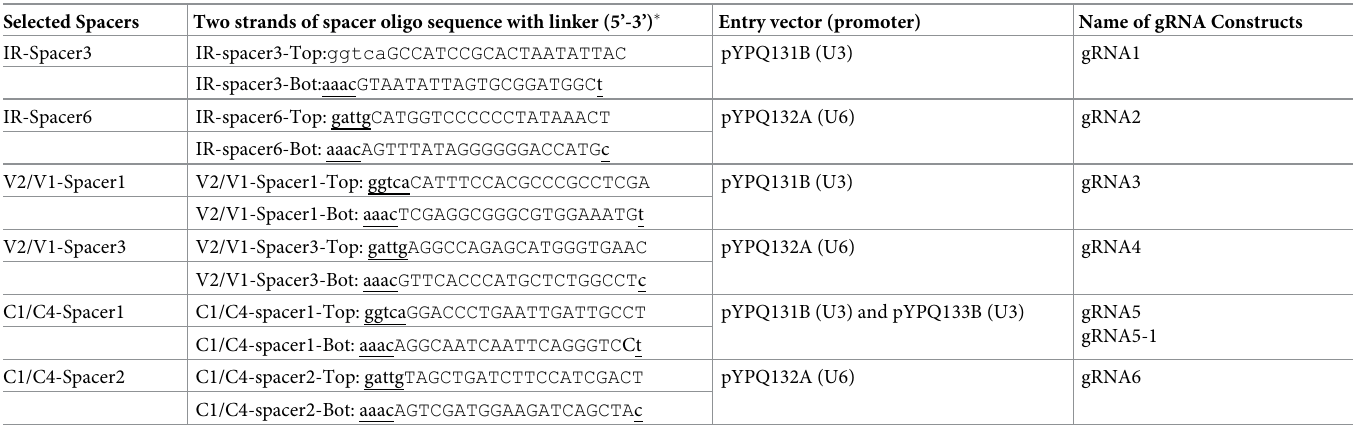
� Spacer sequences (Top) and its complimentary sequences (Bot) were synthesized with addition of linker (underlined) as required for their cloning into GoldenGate entry vectors. The Top and Bot sequences were annealed to each other to develop double stranded spacer molecule for cloning. The vector has the promoter and gRNA scaffold. After cloning the spacer sequence along with scaffold form the functional